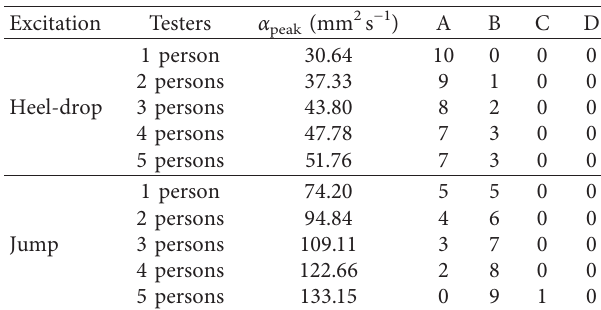
Table 6: Results of